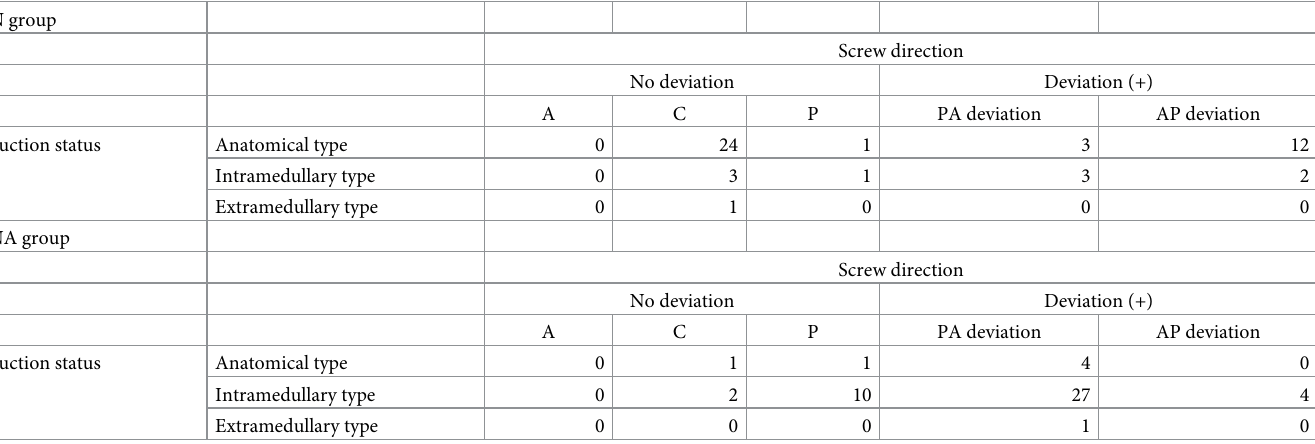
Table 2. Reduction status and screw direction in the BFN and PFNA